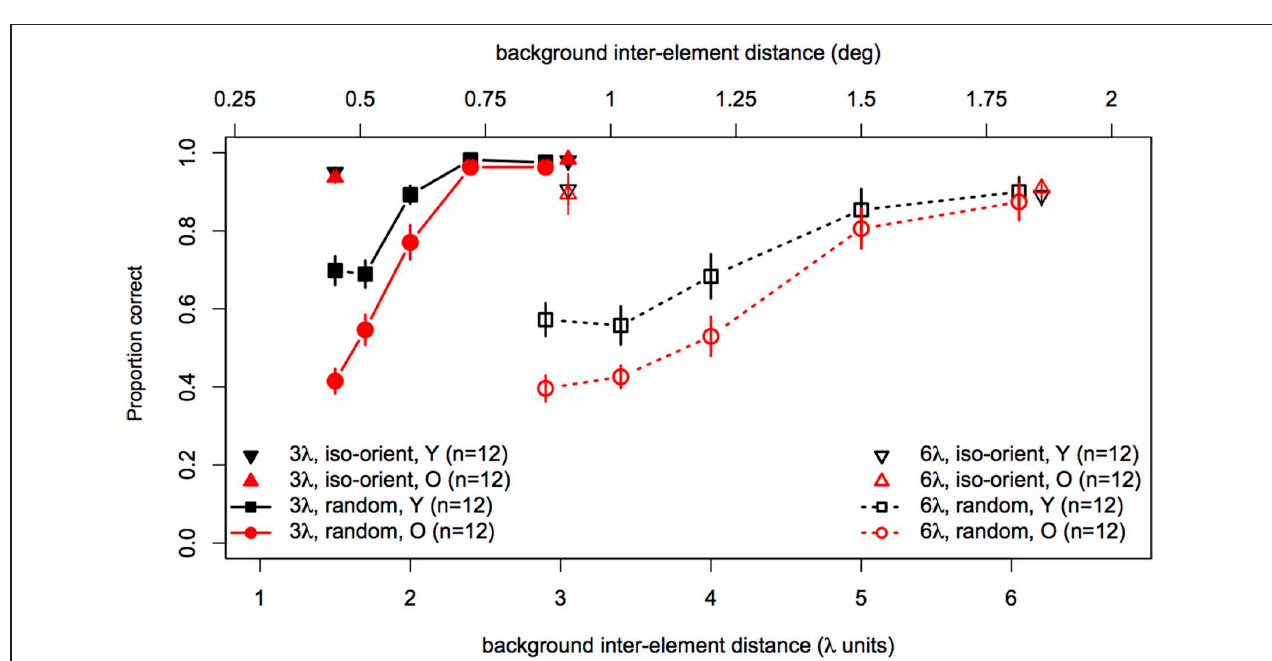
and red circles show younger and older subjects’ performance in the random background condition. Solid lines and filled symbols show data for contours with 3 λ spacing and dotted lines with open symbols show data for contours with 6 λ spacing. Error bars represent ±